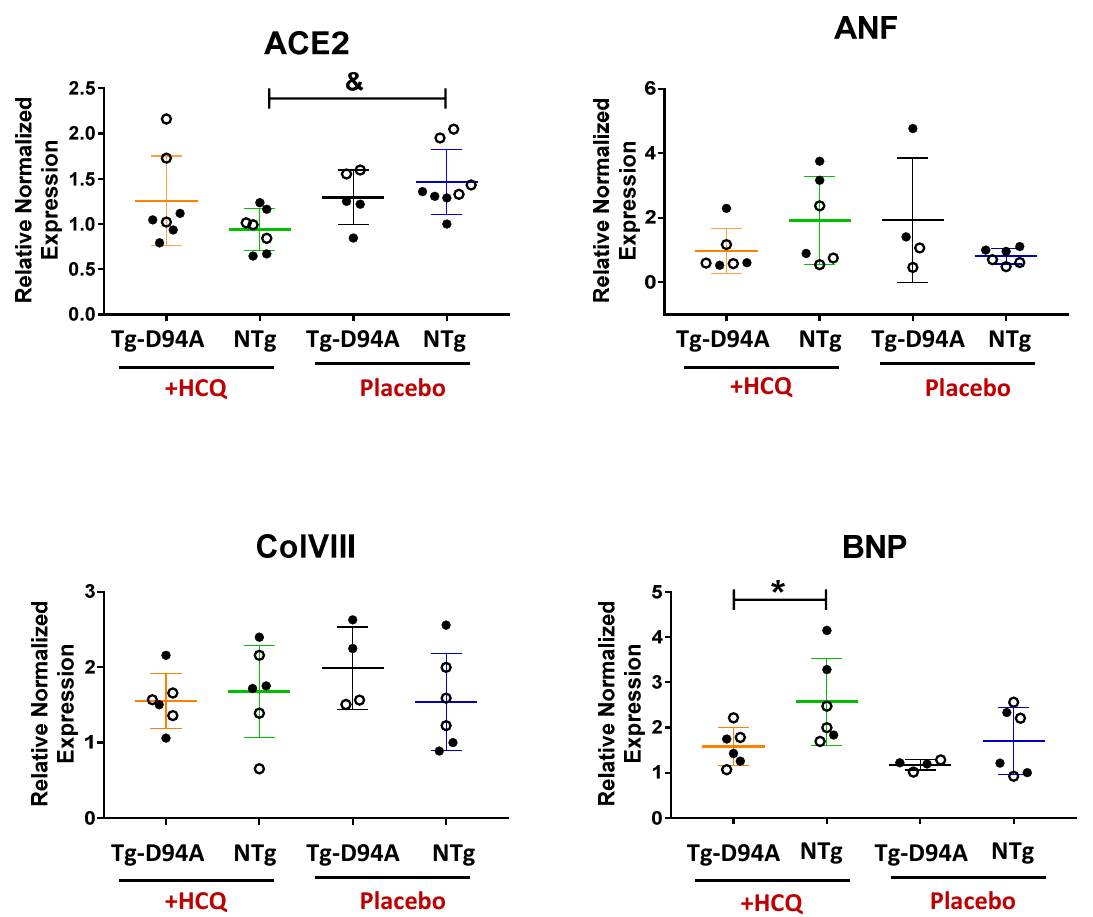
Figure 6. Gene expression profiles in HCQ- vs. placebo-treated Tg-D94A and NTg hearts. Expression of ACE2, ANF, BNP, and ColVIII was determined in the hearts of placebo-treated Tg-D94A vs. NTg mice and presented as relative expression normalized to the level of placebo-treated male NTg mouse (expression = 1). Data are the mean ± SD of n = N o animals. N o = 6–7 for HCQ-treated Tg-D94A and N o = 4–5 for placebo-treated Tg-D94A. N o = 6–7 for HCQ-treated NTg mice and N o = 6–8 for placebo-treated NTg mice. Females are depicted by open symbols and males by closed symbols. Statistical analysis was calculated by two-way ANOVA followed by Sidak’s multiple comparisons test with significance depicted as * p < 0.05 for HCQ-treated Tg-D94A vs. NTg mice and & p < 0.05 for HCQ- vs. placebo-treated NTg mice.